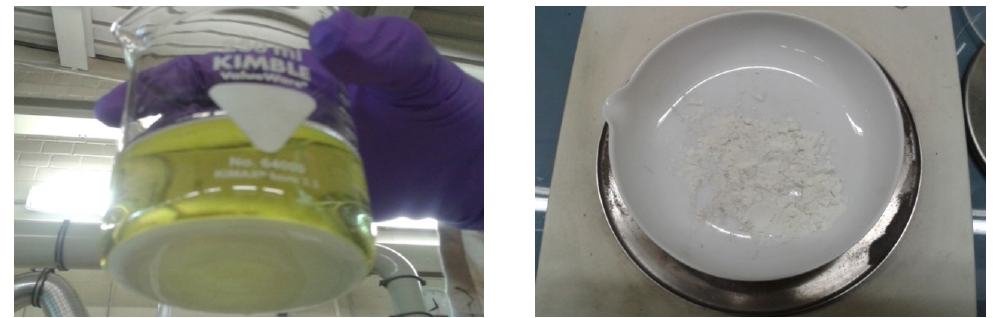
Figure 8. The obtained powder after precipitation with oxalic acid, filtration and washing.